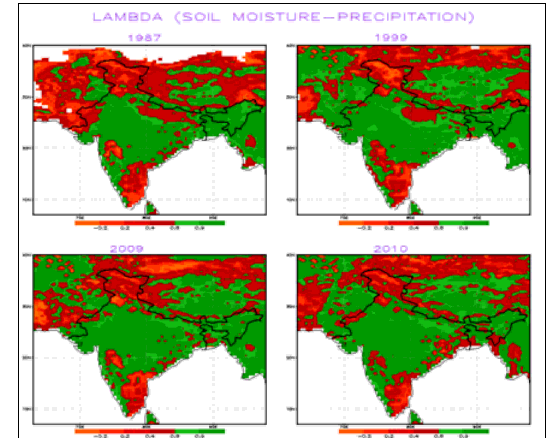
Figure 8. Soil moisture precipitation feedback λ NC (SM, P) using BATS scheme for El Niño (1987,2009), La Niña (1999,2010)